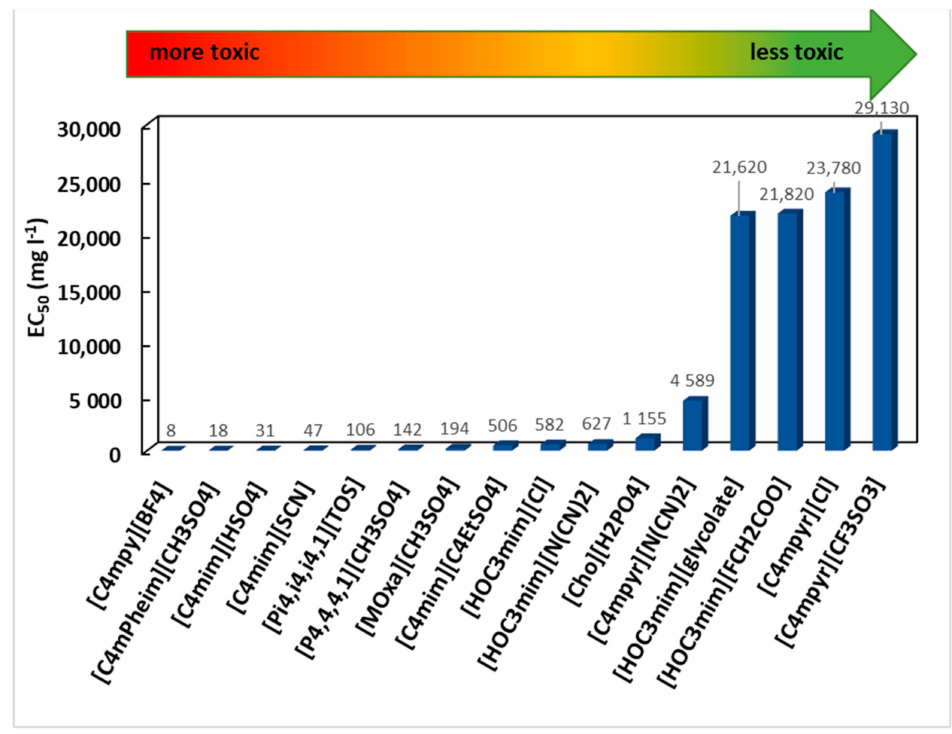
Figure 2. EC 50 values for the ILs towards A. fischeri studied by Hern á ndez-Fern á ndez et al. [36]. Other work using A. fischeri was the one published by Ghanem et al. [37], where after the synthesis and characterization of four amino acid-derived ILs (AAILs), their toxicologic effect towards a green algae and A. fischeri was studied. The AAILs synthe- sized were: 1-(2-hydroxyethyl)-3-methylimidazolium glycinate ([OHC 2 mim][Gly]),